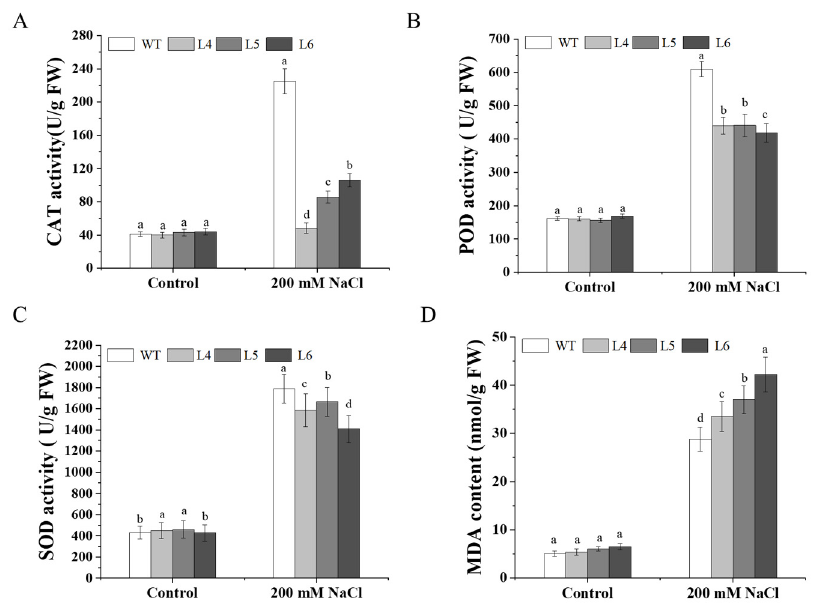
Figure 8. SOD, POD, and CAT activity and MDA content in transgenic Arabidopsis and WT plants under irrigation with 200 mM NaCl for 7 days: ( A ) CAT activity (U/g FW), ( B ) POD activity (U/g FW), ( C ) SOD activity (U/g FW), ( D ) MDA content. Data presented as mean ± SE ( n = 3). Different letters indicate significant differences among L4, L5, L6, and WT at p < 0.05.